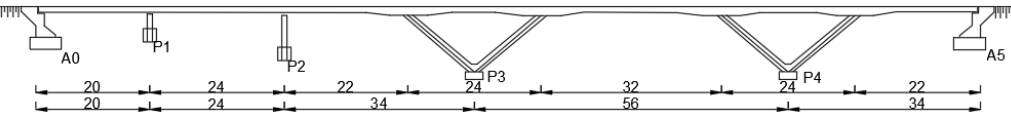
Figure 1. Elevation layout of the